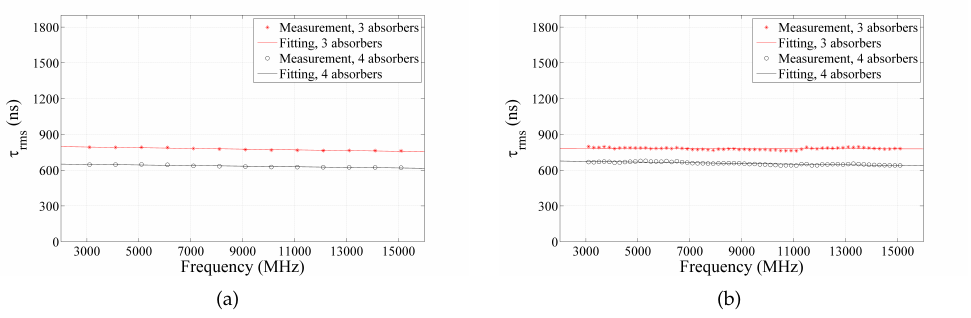
Figure 10. (color online) RMS delay spread in the NIM RC calculated over ( a ) 1000 MHz bandwidth; and ( b ) 200 MHz